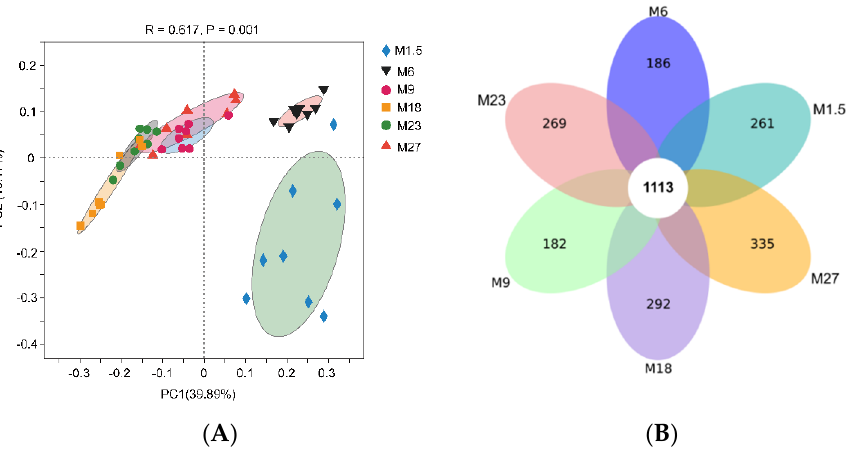
Figure 1. ( A ) Number of shared and unique bacterial OTUs (operational taxonomic units) within each age across all stages of dairy cattle. ( B ) Principal coordinate analysis (PCoA) with Bray–Curtis dissimilarity of the rumen microbial community in different stages of dairy cattle at the genus level. M1.5: age 1.5 months dairy cattle; M6: age 6 months dairy cattle; M9: age 9 months dairy cattle; M18: age 18 months dairy cattle; M23: age 23 months dairy cattle; M27: age 27 months dairy cattle.